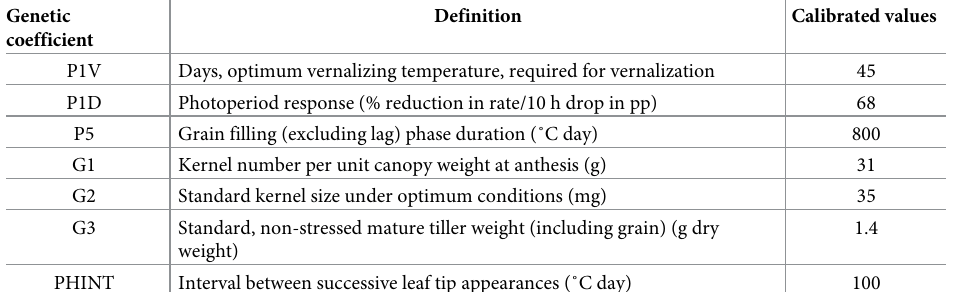
Table 2. Genetic coefficients calibrated for the 2013–2014 and 2014–2015 seasons. Genetic